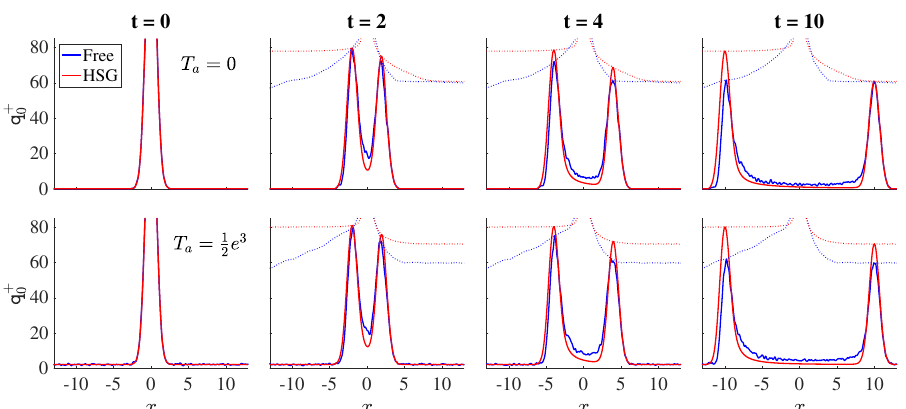
Figure 7: Particle density in the HSG-model (red) compared to the particle den- sity that would result from free evolution of the same initial conditions (blue). The top / bottom rows correspond to the absence / presence of a bath. The peak in the first column has been cut so as to show the remaining figures more clearly. The dotted curves represent the change in the height of the local maxima of the spectral densities as function of time. Red and blue curves generally differ in the height of the local maxima as well as the shape of the